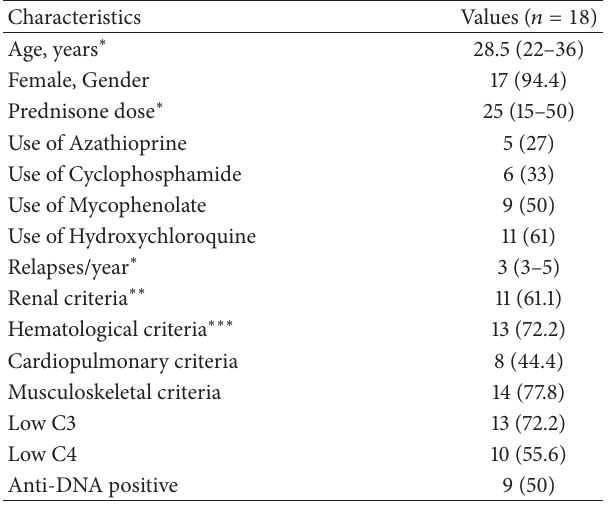
Table 1: Baseline characteristics of the 18 systemic lupus erythe- matosus patients and their main refractory and active